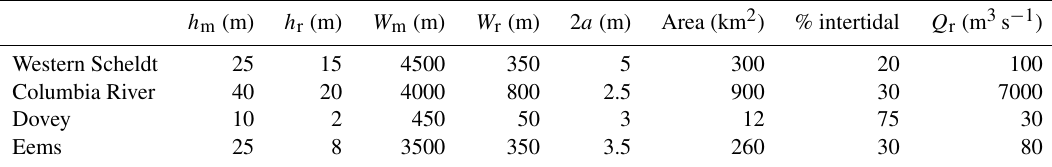
Table 1. Characteristics of the estuaries used in this study. h m is the depth at the mouth, h r is the depth at the landward river, W m is the width at the mouth, W r is the width at the landward river, a is the tidal amplitude, “Area” is the surface area, “% intertidal” is the percentage of intertidal area and Q r is the river